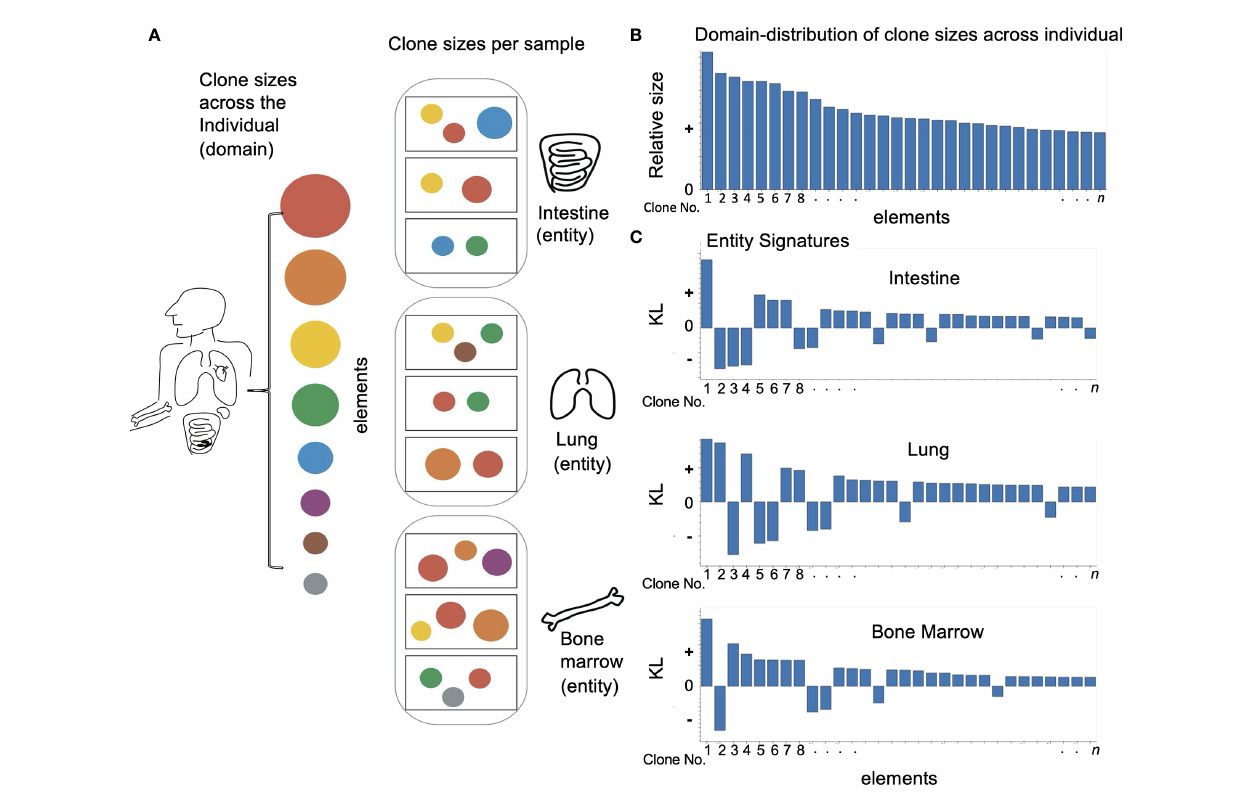
FIGURE 1 | Applying domain based LPA to immune data: (A) Looking at an individual immune repertoire we can divide it into clones of different sizes (represented here by circles of different colors and sizes). When we look at different tissues (oval frames) we fi nd they each have their own skewed set of clone types and clone sizes which differ from the overall picture and each other. The samples in each tissue (rectangular frames) show and even more skewed image of the overall repertoire. (B) To apply domain based LPA we must fi rst de fi ne a domain – here the individual immune repertoire and the elements of which it is comprised – clones. (C) We can then create for each sub-category or entity in the domain a signature – here we see a signature for every tissue. As described in Methods the signature has two values - a size which re fl ects how different the element is in a given entity. i.e. how different clone size is in a given tissue and a sign: “ + ” if the clone is overrepresented compared to the overall repertoire and “–” if the clone is absent or